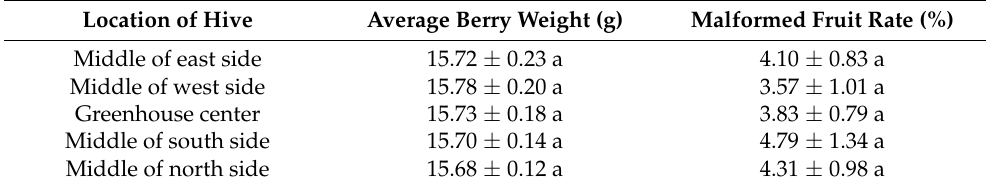
Table 6. Impacts of diverse hive locations with only one hive (bee number is 8000).